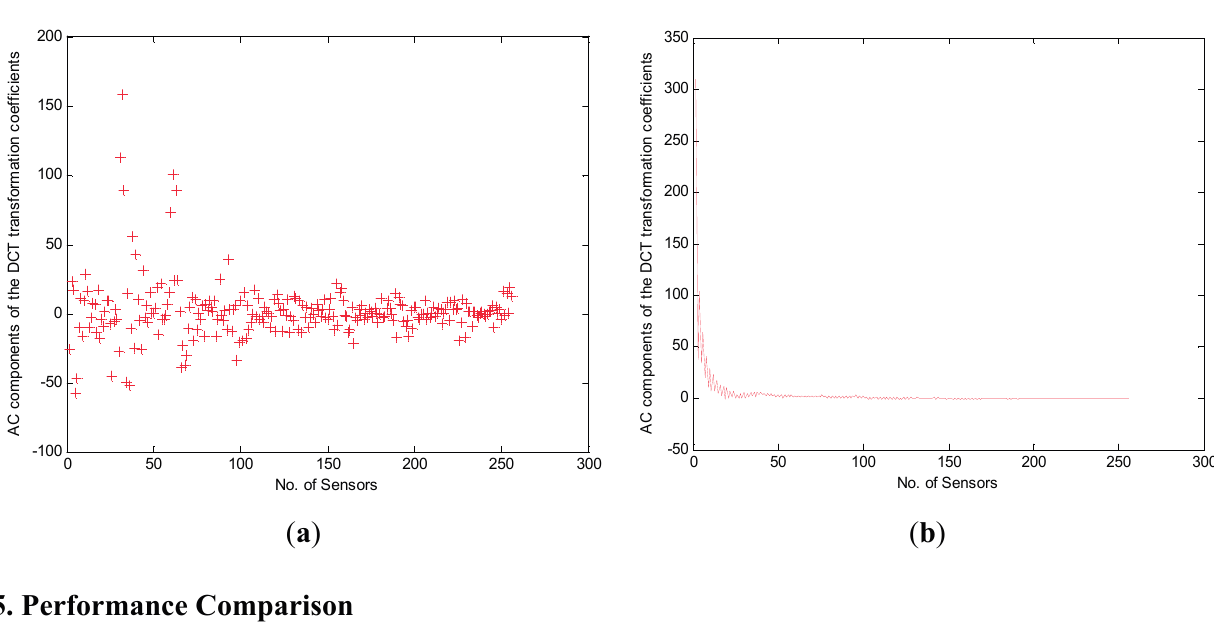
Figure 6. ( a ) Sparsity of unsorted monitored data values during the preprocessing; ( b ) Sparsity of sorted monitored data values during the